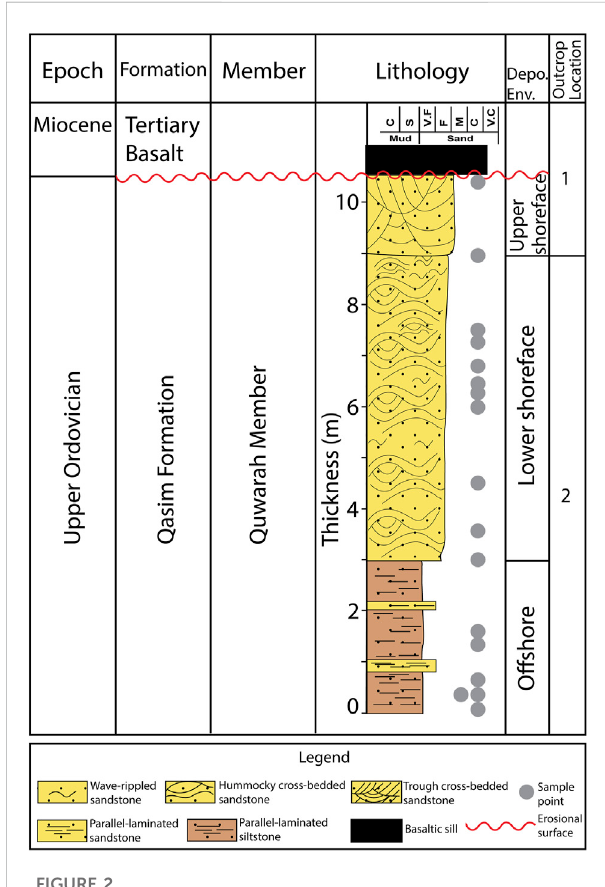
FIGURE 2 Stratigraphic column showing the age of the studied Qasim Formation,distributionofsedimentaryfacies,andlocationofoutcrops and sampled